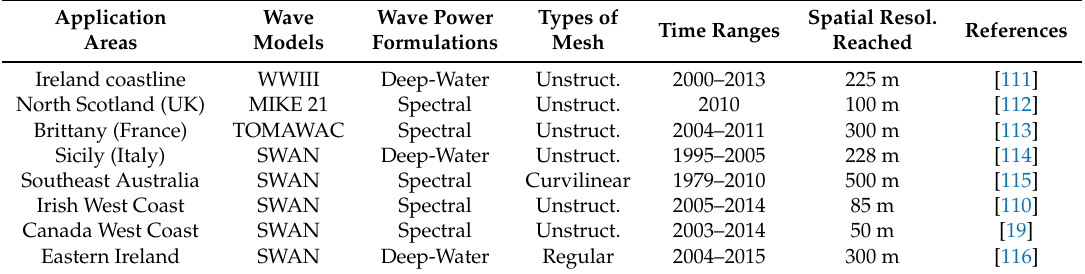
Table 8. Examples of coastal numerical wave energy resource